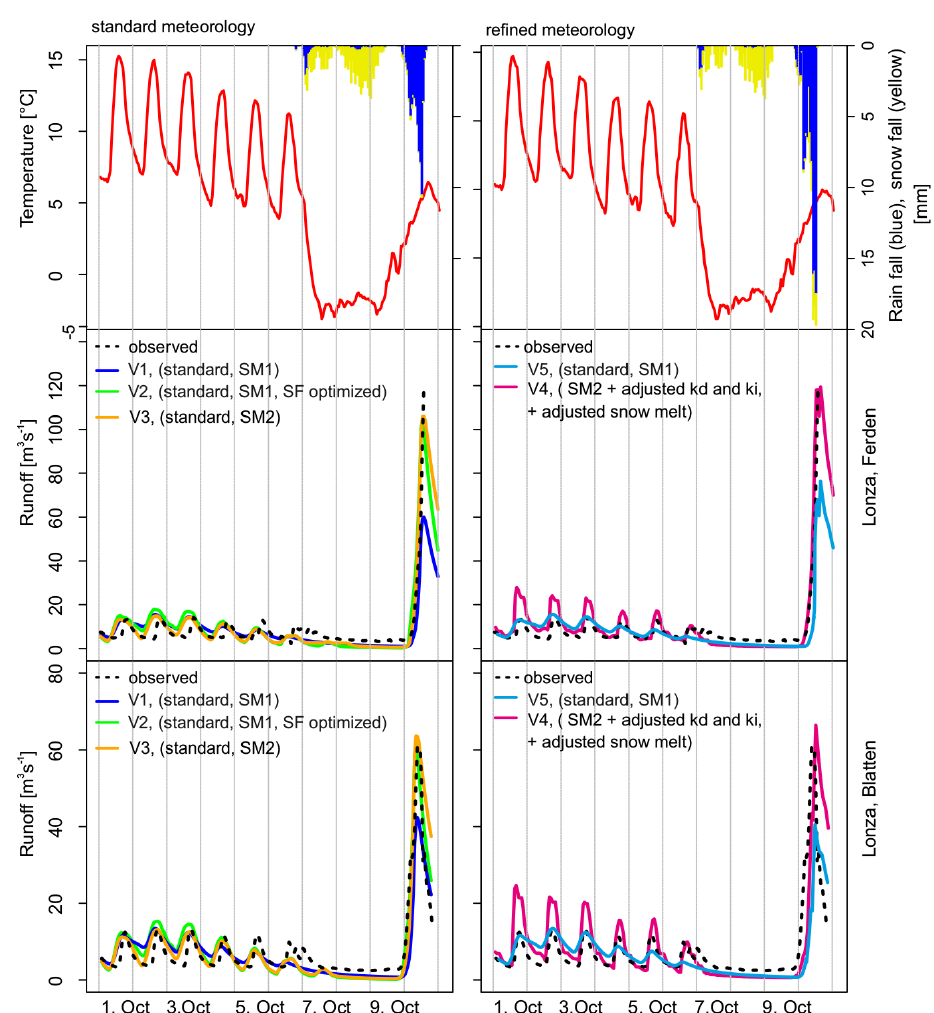
Figure 7. Retrospective modeling of the flood event at two gauges, Lonza, Ferden and Lonza, Blatten, under standard (left column) and refined meteorology (right column) shows that the standard WaSiM-ETH model setup (V1, blue lines) is not able to replicate the observations (black dotted lines), while the three peak-optimized model setups (V2, V3, V4, orange, green, magenta lines) are capable of matching the observations. Meteorology is depicted as temperature (red line), rainfall (blue) and snowfall (yellow) in the top row.